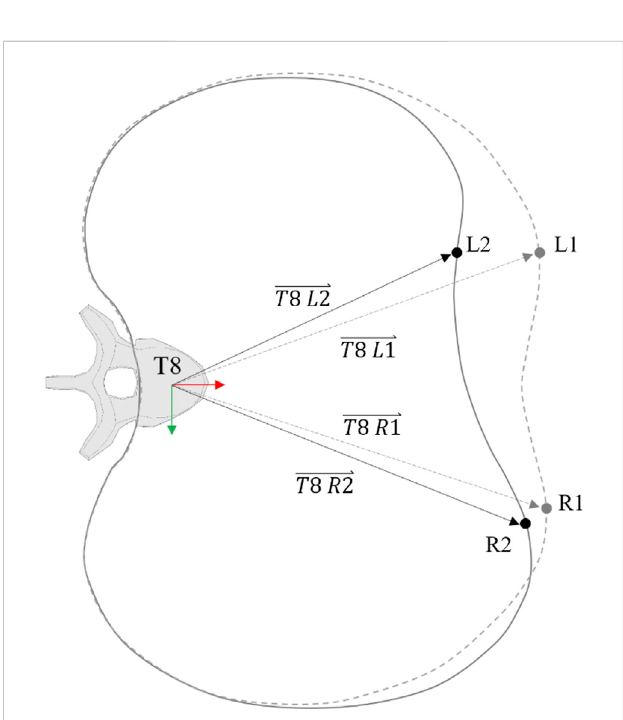
FIGURE 2 Chestde fl ectionrepresentationalongoneriblevel.Theslashedline represents the undeformed rib pro fi le.